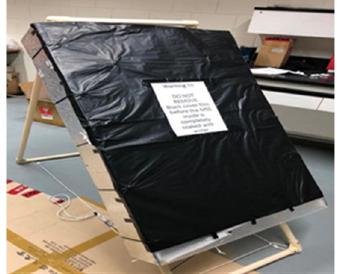
Figure 4. Assembled prototype in the KISR laboratory before commissioning.